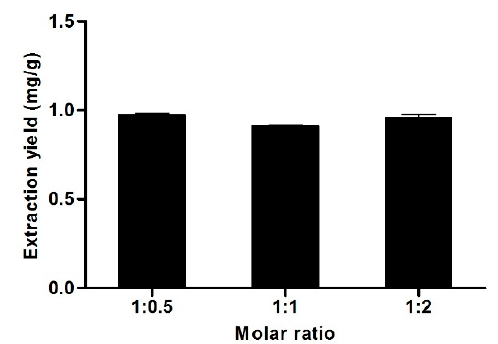
Figure 6. Rutaecarpine extraction yields of La-Buta DESs with different molar ratios. La-Buta DES aqueous solution with different molar ratios was used as the solvent to extract at a solid-liquid ratio of 1:50 with ultrasound at 35 °C and 500 W for 40 min. Data represent mean ± S.D. of triplicated experiments. Table 4. Chemical shifts and relative numbers of some protons in the 1 H NMR spectra of La-Buta DESs with different molar ratios (500 MHz, DMSO- d 6 , δ in ppm). Levulinic Acid Molar Ratio